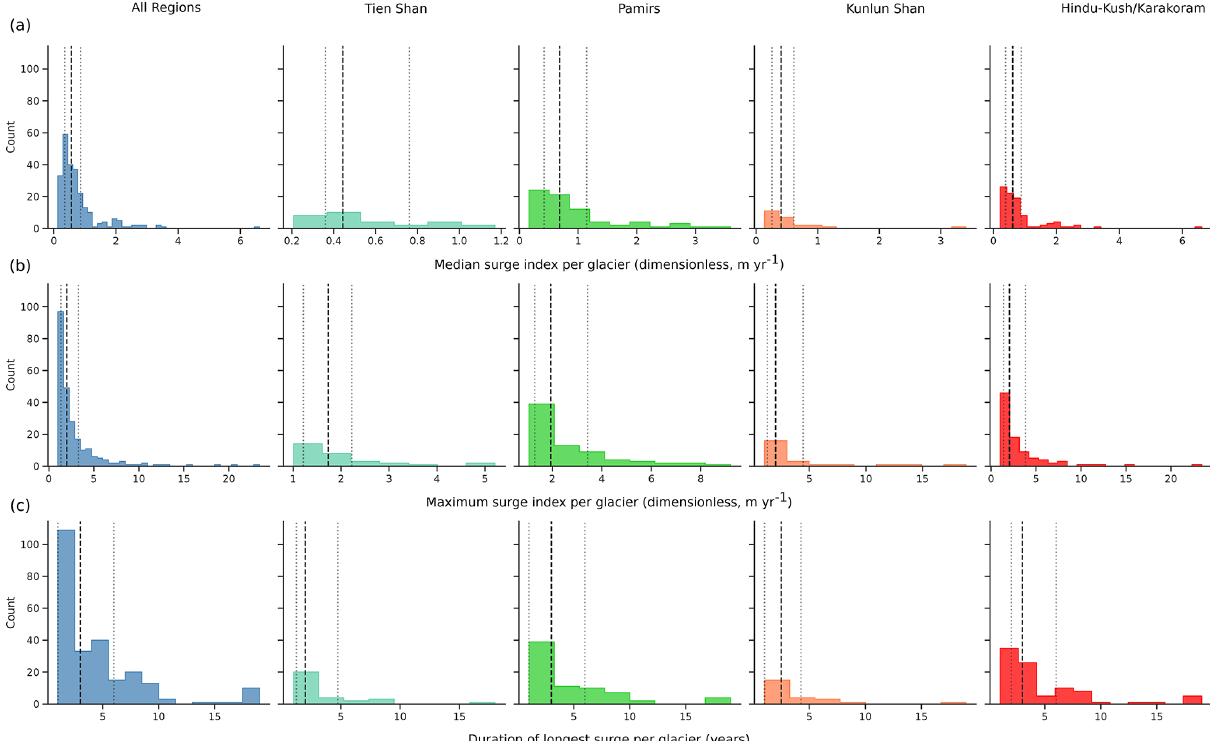
Figure 11. Distribution of (a) median surge index per glacier, (b) maximum surge index per glacier and (c) duration of the longest active phase per glacier for the whole HMA and four of the larger HIMAP regions. Dashed lines represent the median of each distribution; dotted lines are the 25th and 75th percentiles.